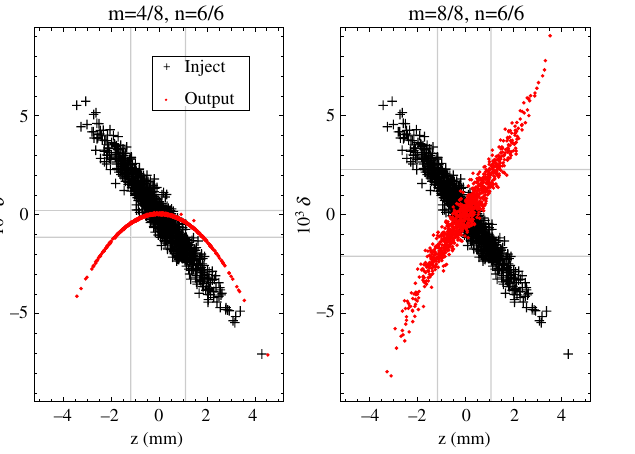
FIG. 5. Tilted 1000-particle beam in longitudinal phase space for the FT model, shown after full acceleration (left) and deceleration (right). The input distribution is a tilted Gaussian: each particle ’ s original Gaussian δ coordinate is offset according to the matrix slope from Eq. (35) and Table V; due to the relatively large initial beam size, the edges of the final beam do extend beyond the linear regime.